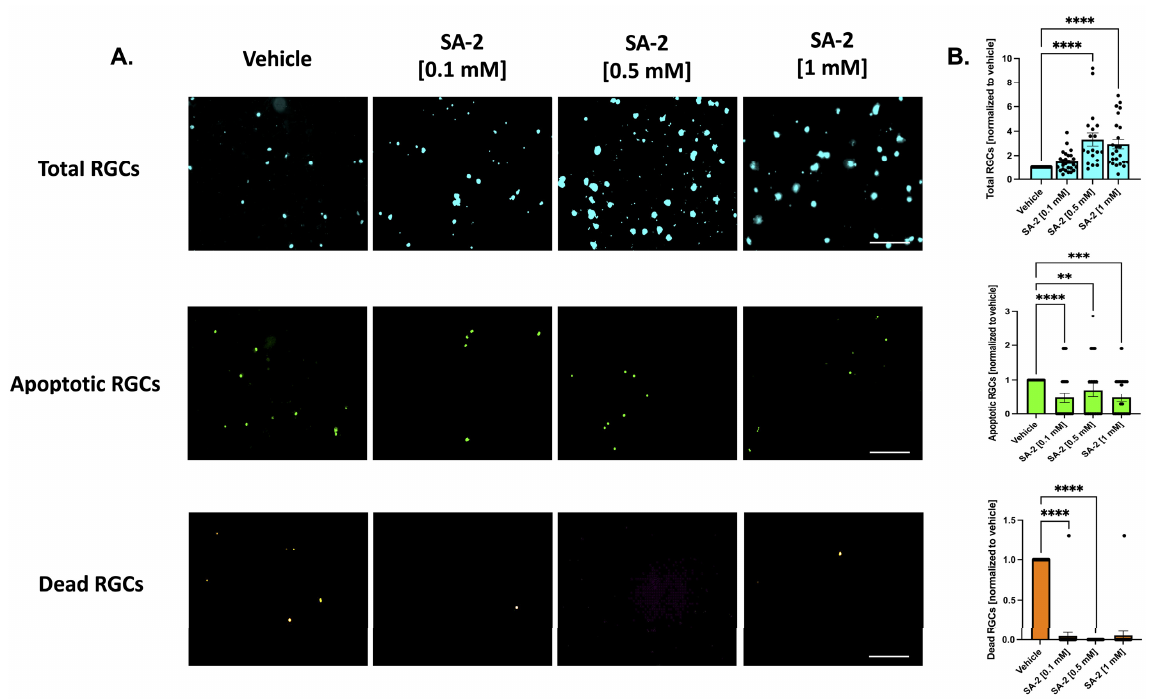
Figure 3. Treatment of primary RGCs from Sprague Dawley rat pups in the presence of neurotrophic factors. ( A ) Representative images of RGCs treated either with vehicle (DPBS) or SA-2 in the presence of neurotrophic factors for 48 h. ( B ) Graph bars represent total (blue, Hoechst 33342), apoptotic (green, active caspase-3 and caspase-7), and dead (orange, propidium iodide) RGC counts as a ratio to the total cells in the vehicle control group. In the presence of neurotrophic factors, SA-2 mediated a significant decrease in apoptotic cells by 30% ( p < 0.01) and a 83.65% ( p < 0.01) decrease in dead cells, using Kruskal–Wallis followed by Dunn’s multiple comparisons. Data represent the mean ± SEM (n = 3 biological replicates). ** p < 0.01, *** p < 0.001, **** p < 0.0001. The scale bar represents 200 µ